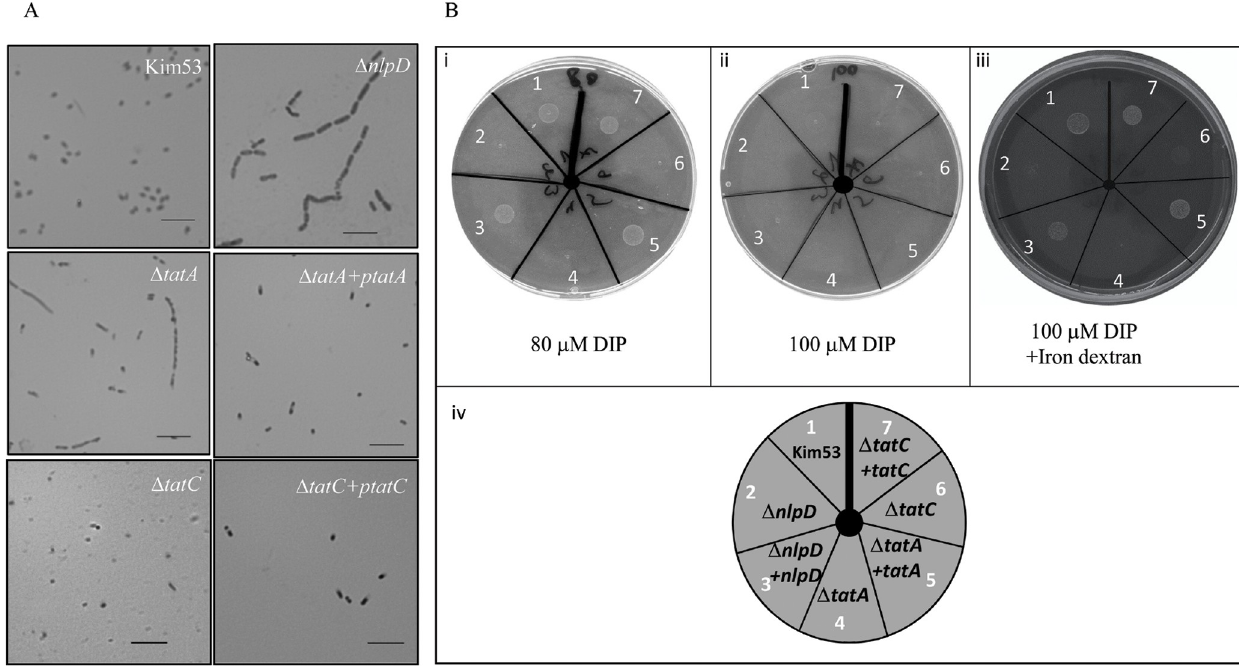
Fig 5. Phenotypic characterization of Y . pestis tat mutants. A. Gram staining of Y . pestis strains wild-type Kim53, Δ nlpD , Δ tatA , Δ tatC , Δ tatA +pt atA and, Δ tatC +pt atC was performed, and bacilli were observed by light microscopy at a magnification of × 1000. Scale bar = 10 μ m. B. Growth of Y . pestis strains under iron-limiting conditions. Y . pestis strains (see description in the lower panel, iv), were grown under iron-limiting conditions (see Materials and Methods). The medium included: 1% agarose, 1 × PMH2, 20 μ M MgCl 2 and 80 μ M DIP (i), 100 μ M DIP (ii) or 100 μ M DIP with addition of iron dextran (0.5mg/ml, iii). The displayed data is one representative experiment.